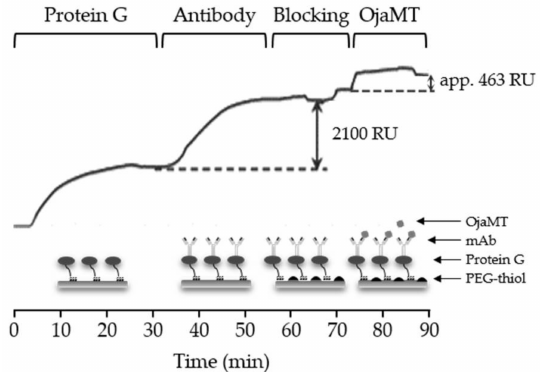
Figure 3. OjaMT detection using SPR chip presenting anti-OjaMT monoclonal antibody (mAb). An antibody (50 µ g/mL) was immobilized on a gold surface, and OjaMT (30 µ g/mL) was then flowed at a rate 10 µ L/min for 10 min. RU stands for response